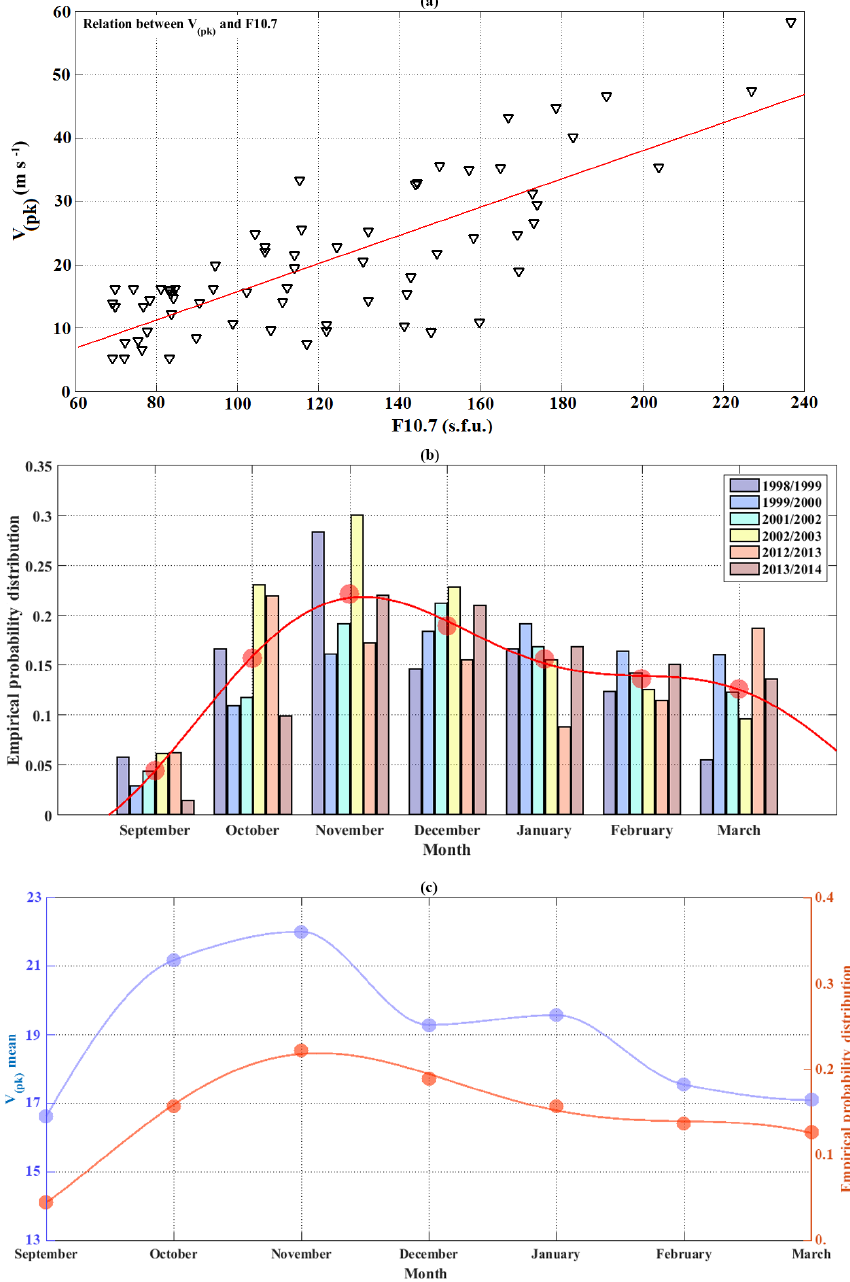
Figure 7. (a) V pk values obtained from SAMI2 model plotted against the solar flux F10.7. (b) Empirical probability distribution of scintilla- tion occurrences during the season from September to March. (c) Comparison between the average patterns of the empirical distribution of scintillation occurrences and the V pk